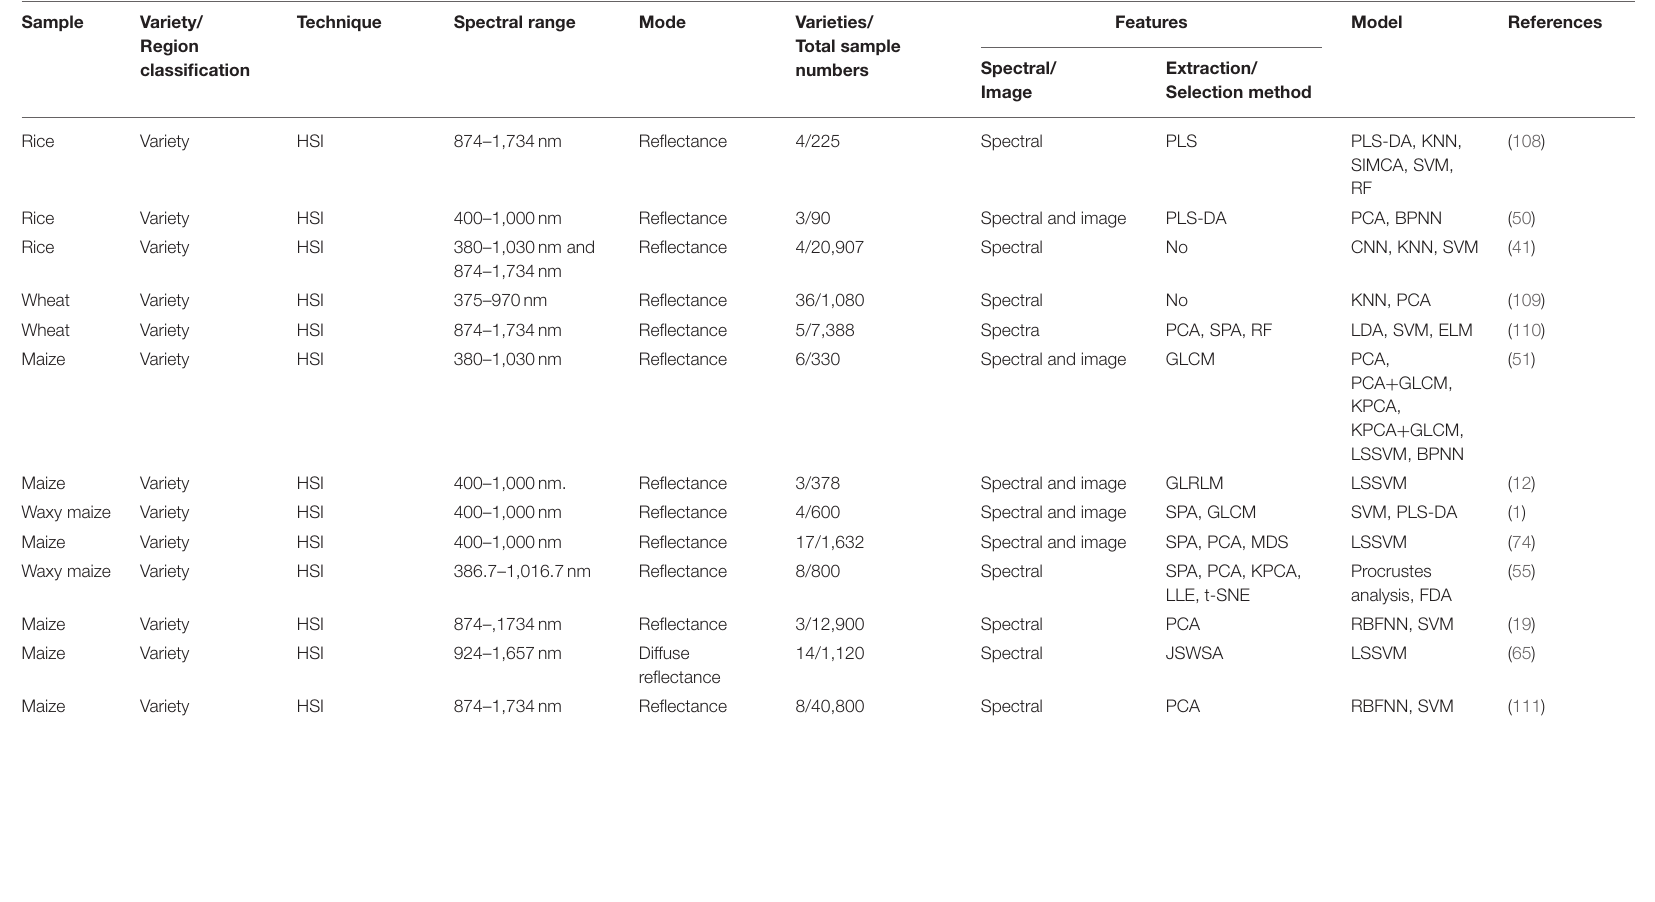
TABLE 3 | Summary of selected references for crop food classification with hyperspectral